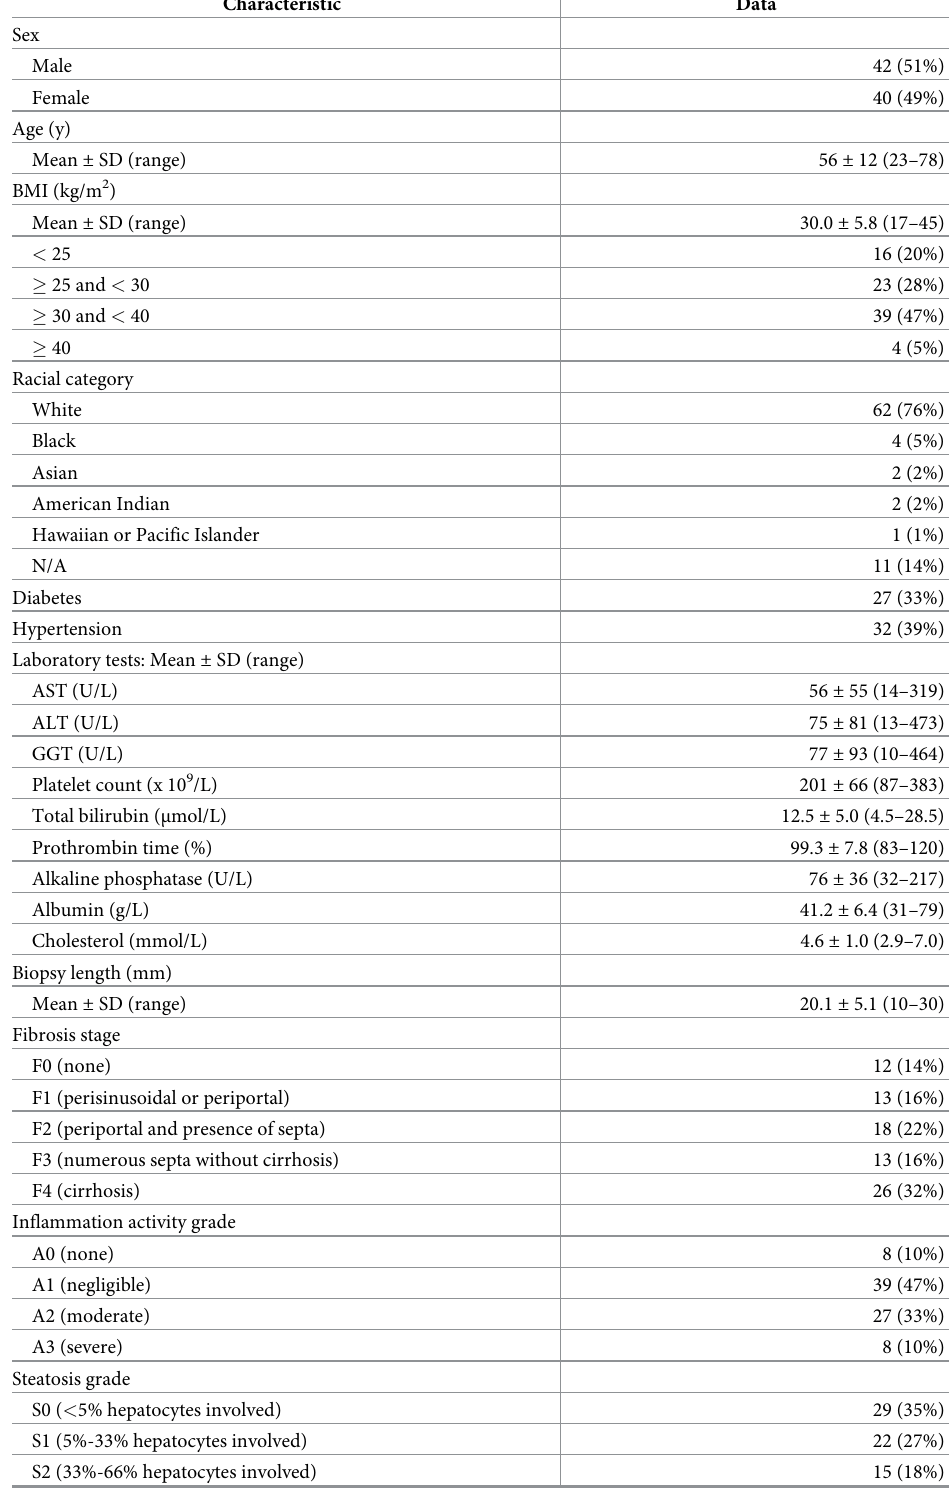
Table 1. Characteristics in 82